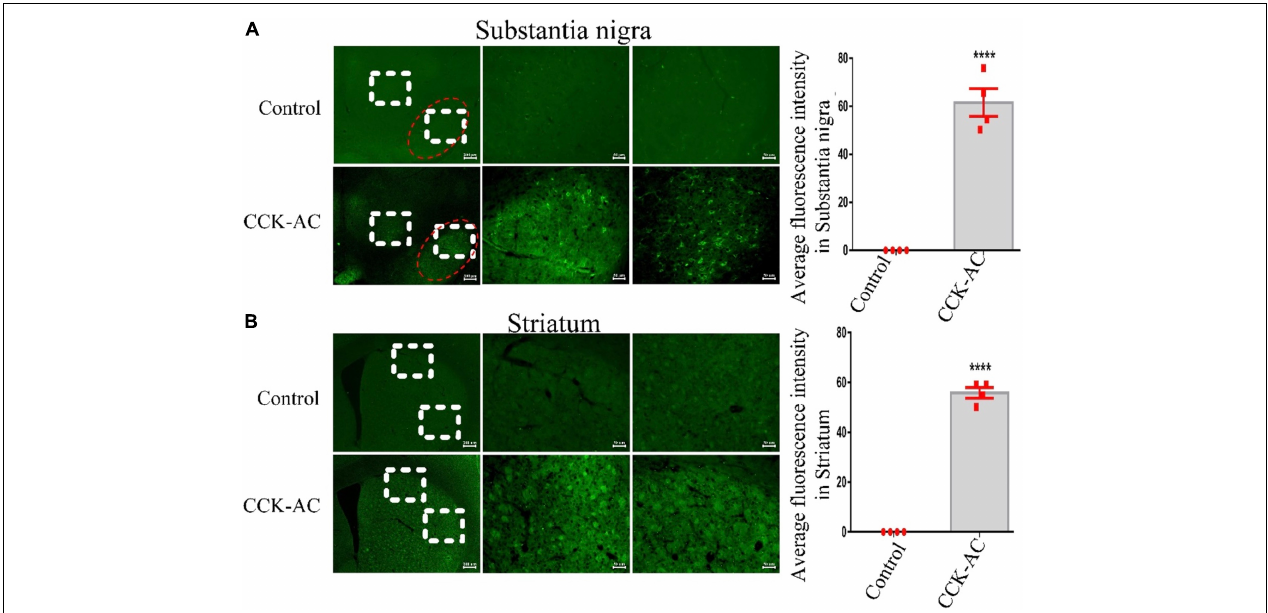
FIGURE 1 | Assessment of CCK analogue for permeability of the BBB. (A) The expression of CCK-AC in the substantia nigra (The region of the red ellipse is substantia nigra pc. Scale bar: 200 µ m, 50 µ m). The expression of CCK-AC in the striatum (Scale bar: 200 µ m, 50 µ m). (B) A difference was found between two groups. **** P < 0.0001, compared with the control group, n = 4 per